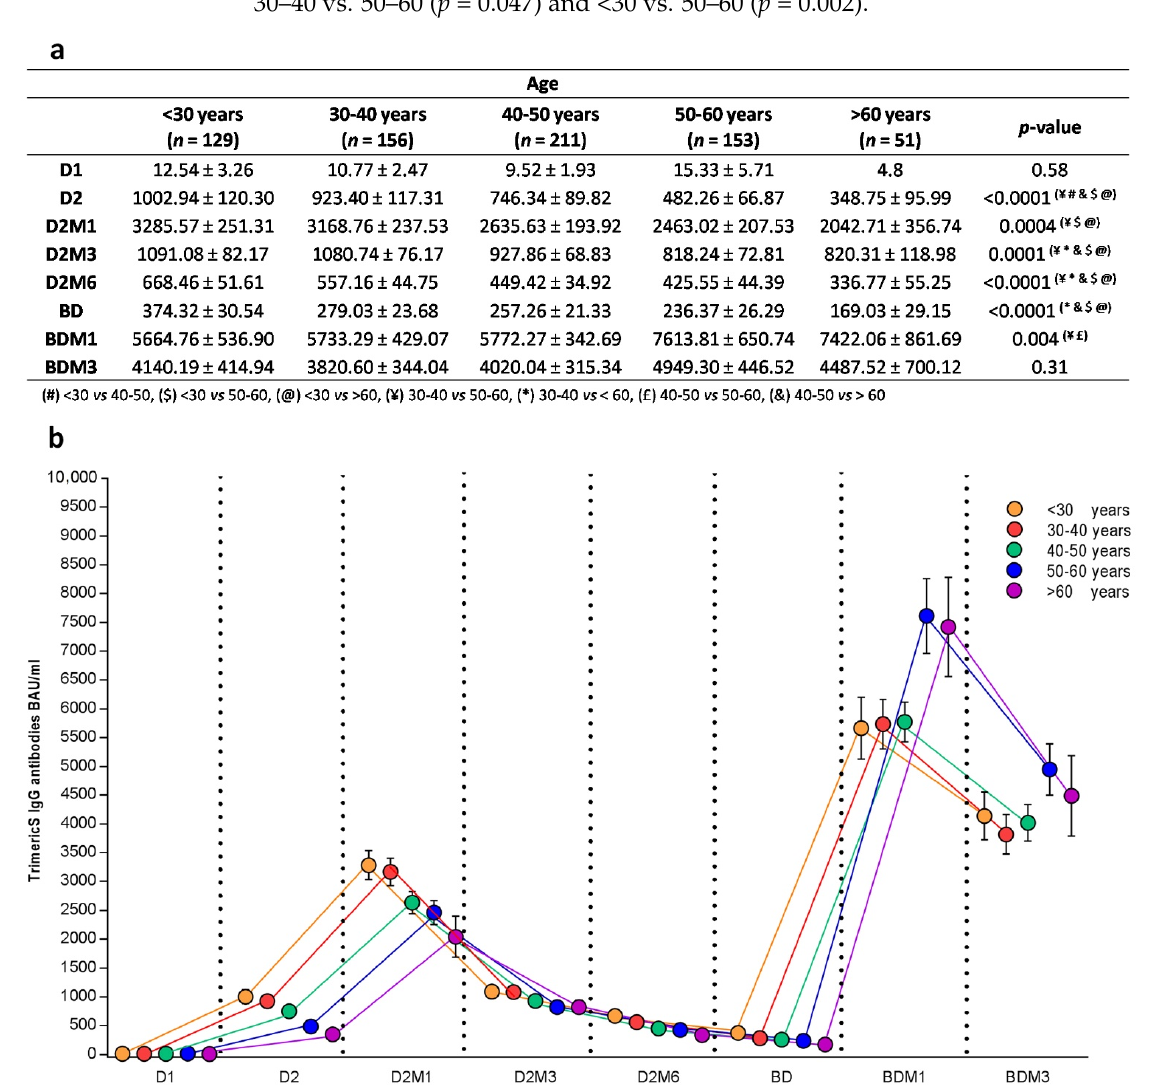
Figure 4. Anti-Trimeric Spike IgG geometric mean titer ( a ), and dynamic ( b ) before and after booster vaccination according to age group (mean ± SE). The nonparametric Kruskal–Wallis test was used for comparison of continuous values between groups. D1, dose 1; D2, dose 2; D2M1, 1 month after dose 2; D2M3, 3 months after dose 2; D2M6, 6 months after dose 2; BD, booster dose; BDM1, 1 month after booster dose; BDM3, 3 months after booster dose; and SARS-CoV-2, severe acute respiratory syndrome-coronavirus-2.